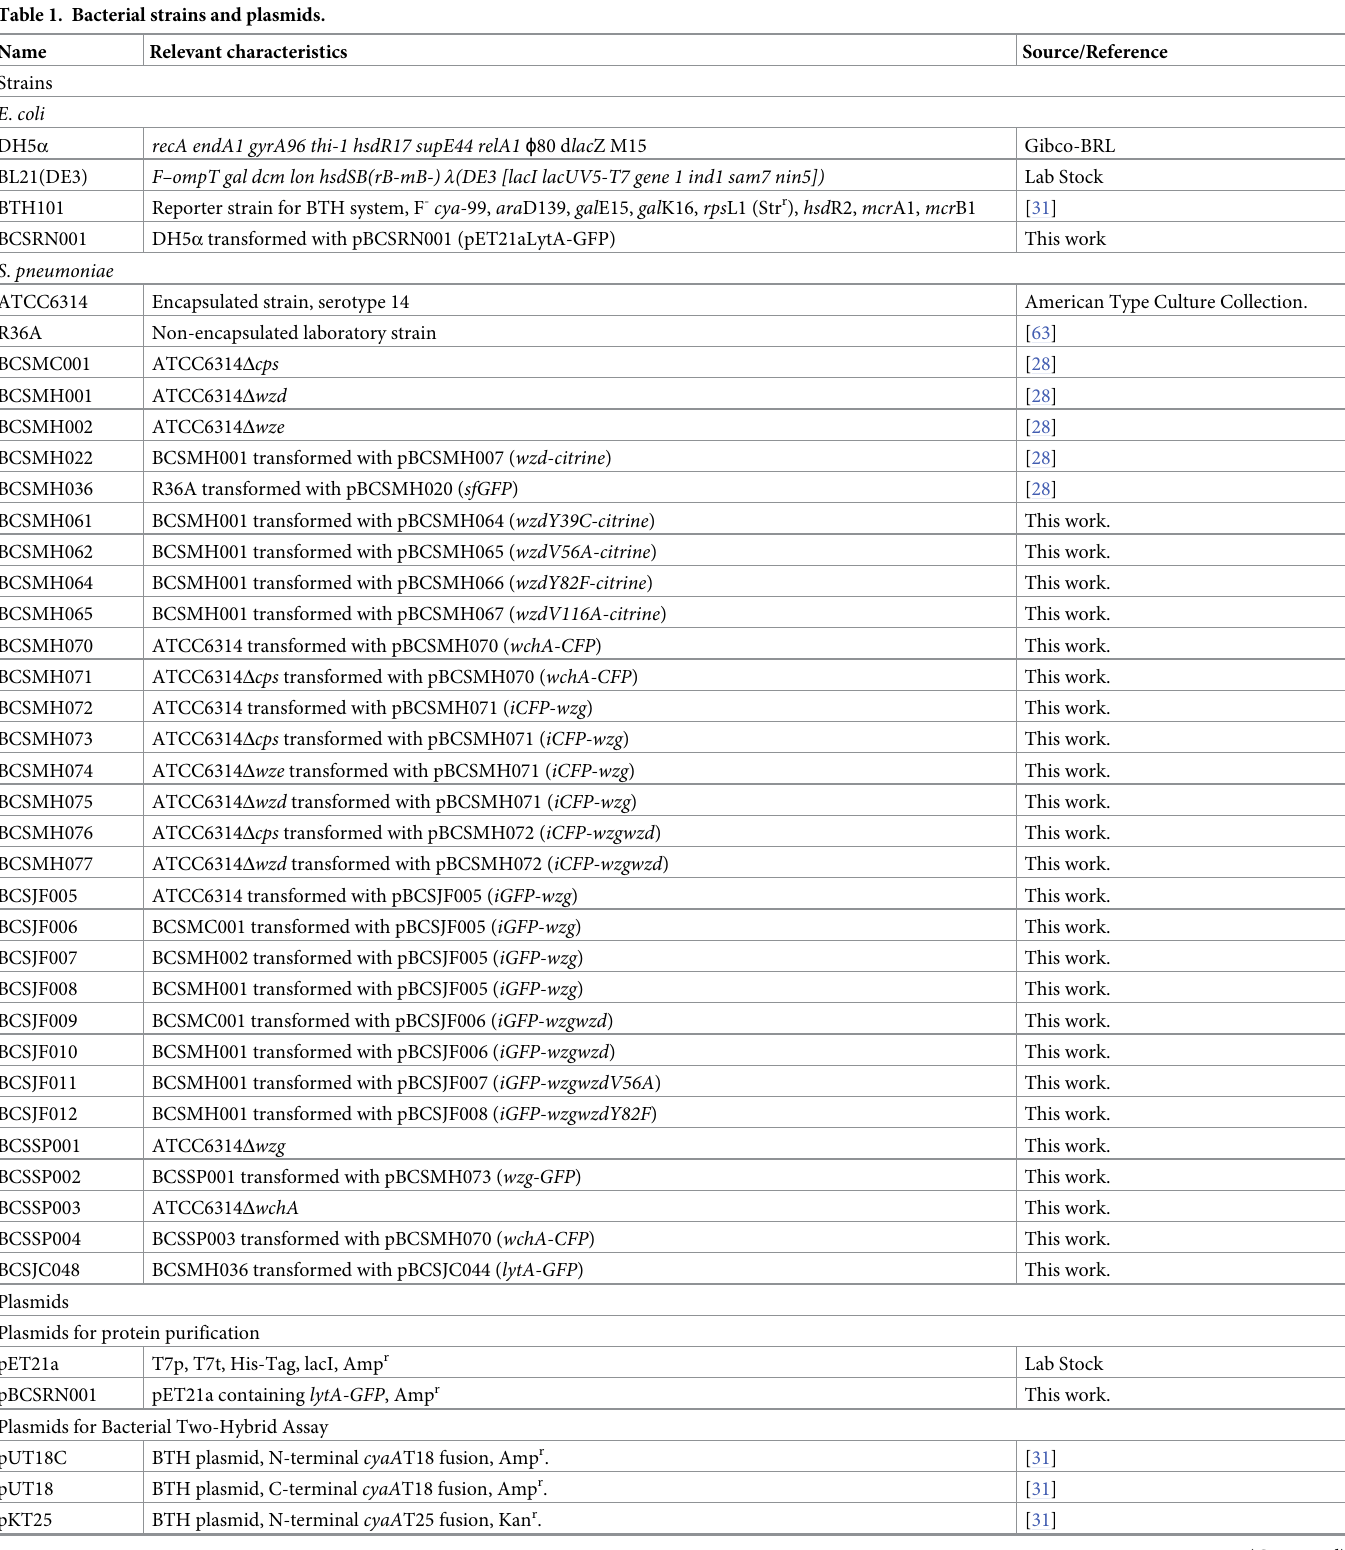
Table 1. Bacterial strains and